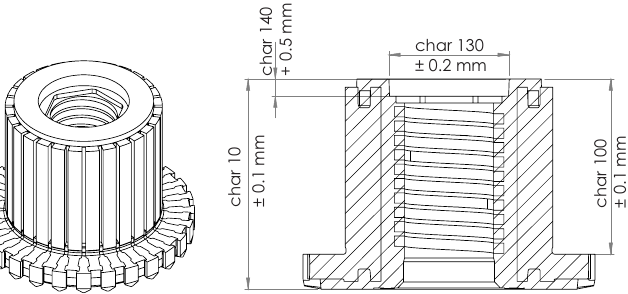
Figure 3. Demonstration of the measured characteristics with tolerances for the product Magnet.